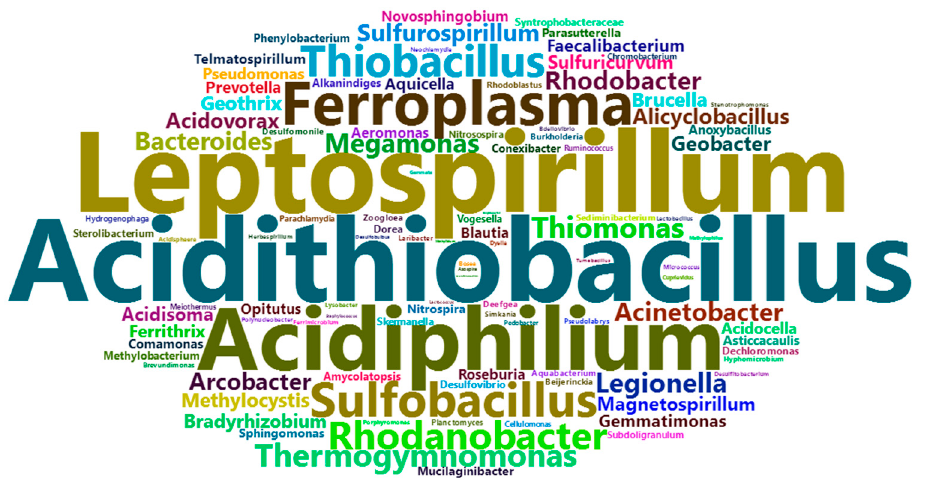
Figure 1. The genera detected in AMD samples from 14 mining areas across South China (data from [24]). The font size is proportional to the average relative abundance of the specific genus in microbial communities of AMD ecosystems.